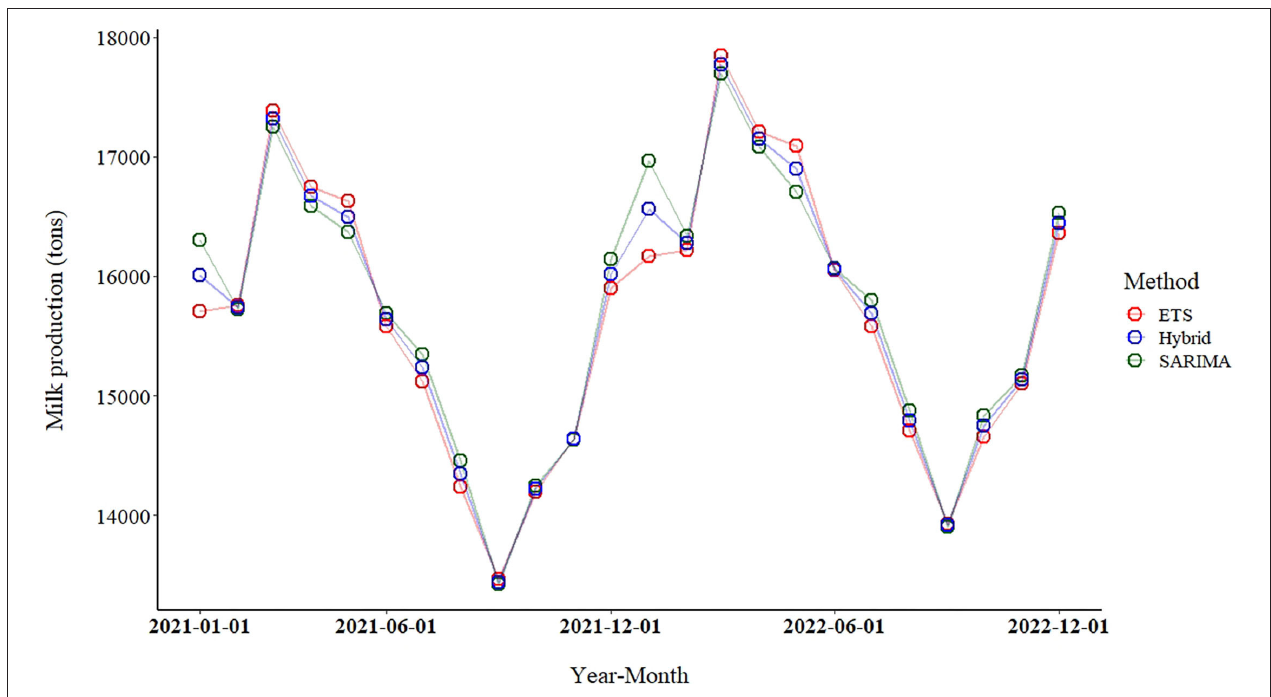
FIGURE 4 | Forecasts of milk production (January 2021–December 2022) using the seasonal autoregressive integrated moving average (SARIMA), error trend seasonality (ETS), and SARIMA-ETS hybrid models applied to the dataset of January 2016–December 2020. Green, red and blue circles represent to the forecast values from SARIMA, ETS and SARIMA-ETS,